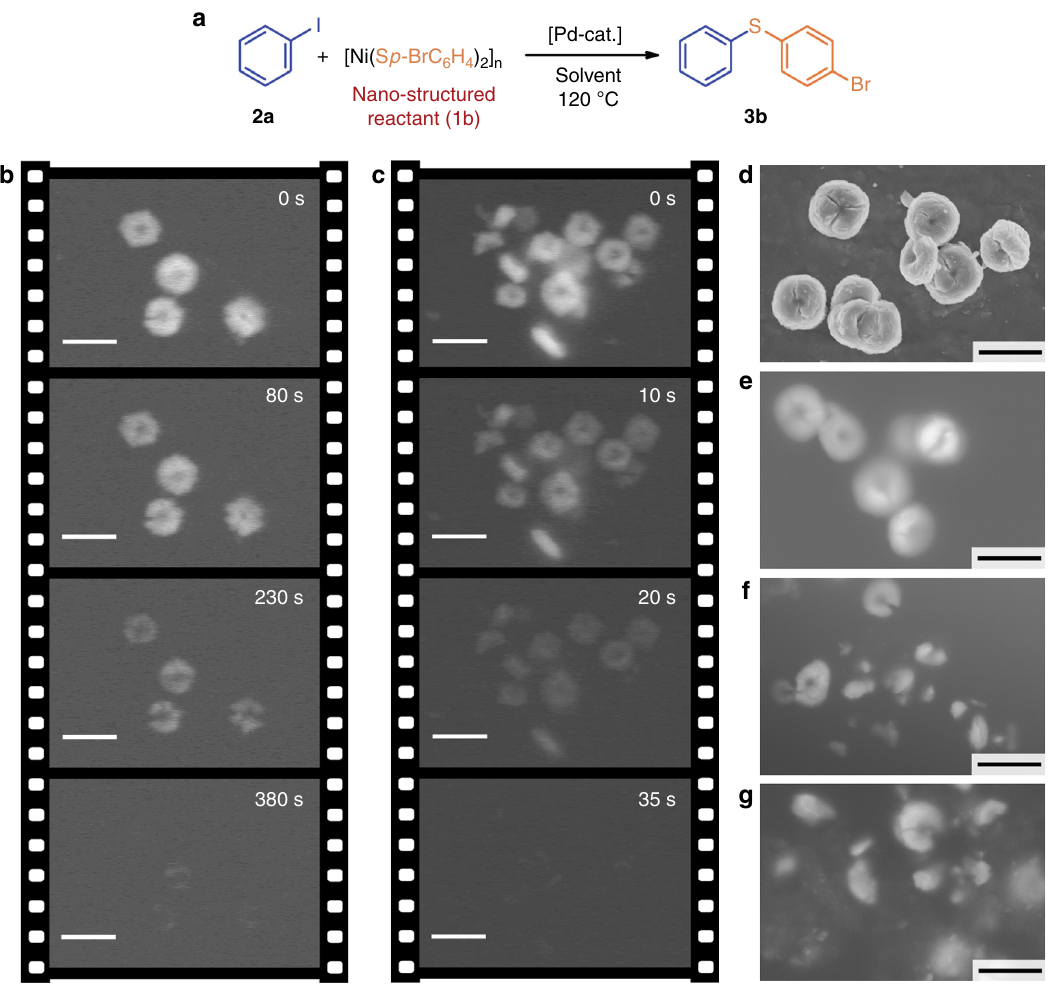
Fig. 4 Liquid-phase SEM monitoring of the C – S cross-coupling reaction. Model C – S cross-coupling reaction between 1b and iodobenzene ( a ). Snapshots taken from SEM videos of dissolution of thiolate 1b particles in Pd(OAc) 2 /dppe system in the absence ( b ) and in the presence ( c ) of iodobenzene; FE-SEM images of 1b particles in the solid phase ( d ) and in isopropanol suspension ( e ); and liquid-phase FE-SEM images of the C – S cross-coupling reaction mixture containing 1b after 45 min ( f ) and 2 h ( g ) of the reaction. Scale bars – 5 μ m for all